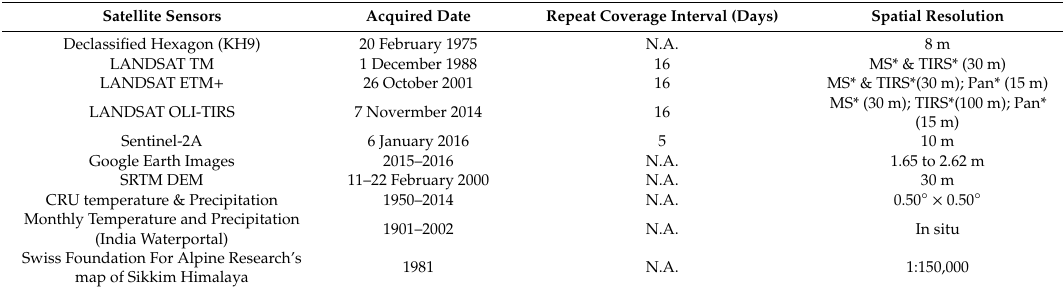
Table 2. Details of the data